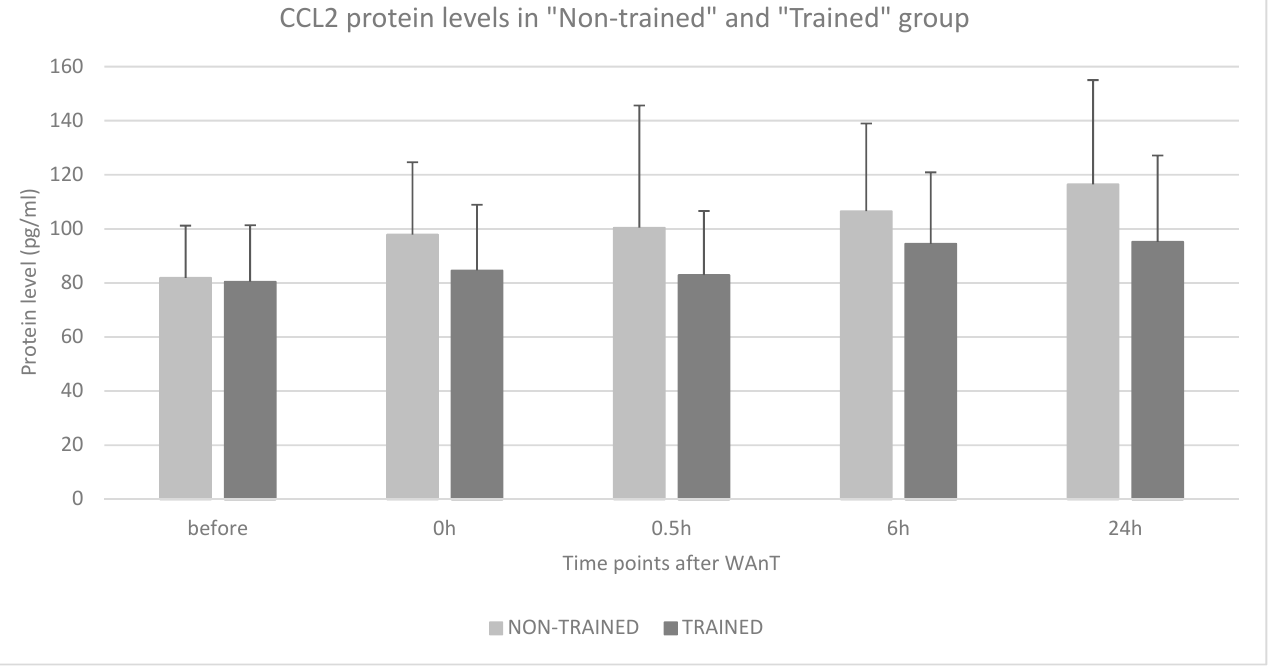
Figure 4. CCL2 protein level changes in “Non-trained” and “Trained” group in four post-tests after WAnT. Table 1. The results of correlation analyses carried out for comparisons between the expression level of the CCL2 gene and the CCL2